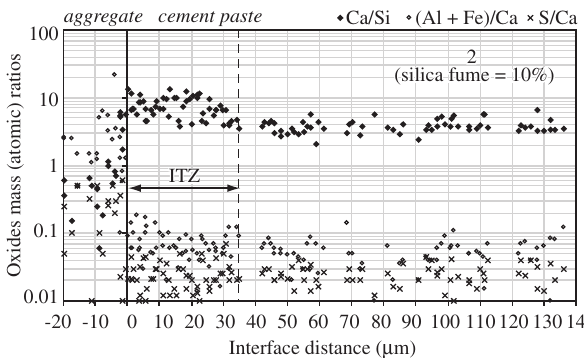
Figure 3. The ratios of Ca/Si, (Al + Fe)/Ca and S/Ca to concrete 3 (S/C = 10%).